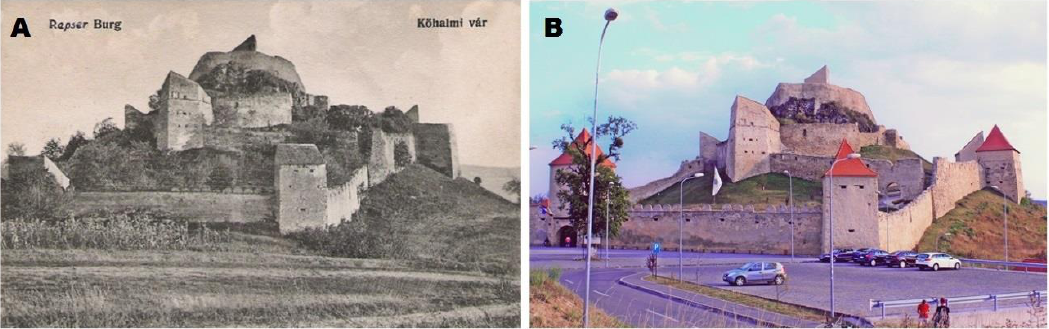
Figure 4: View over the north side of Rupea Fortress, A – before and B – after